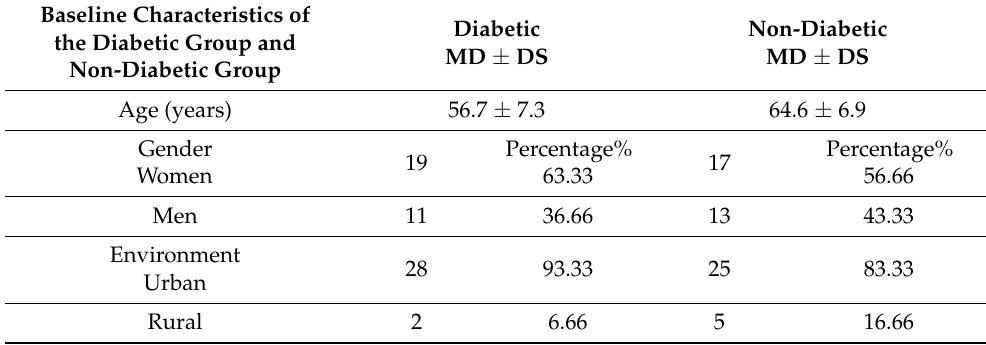
Table 1. Characteristics of the